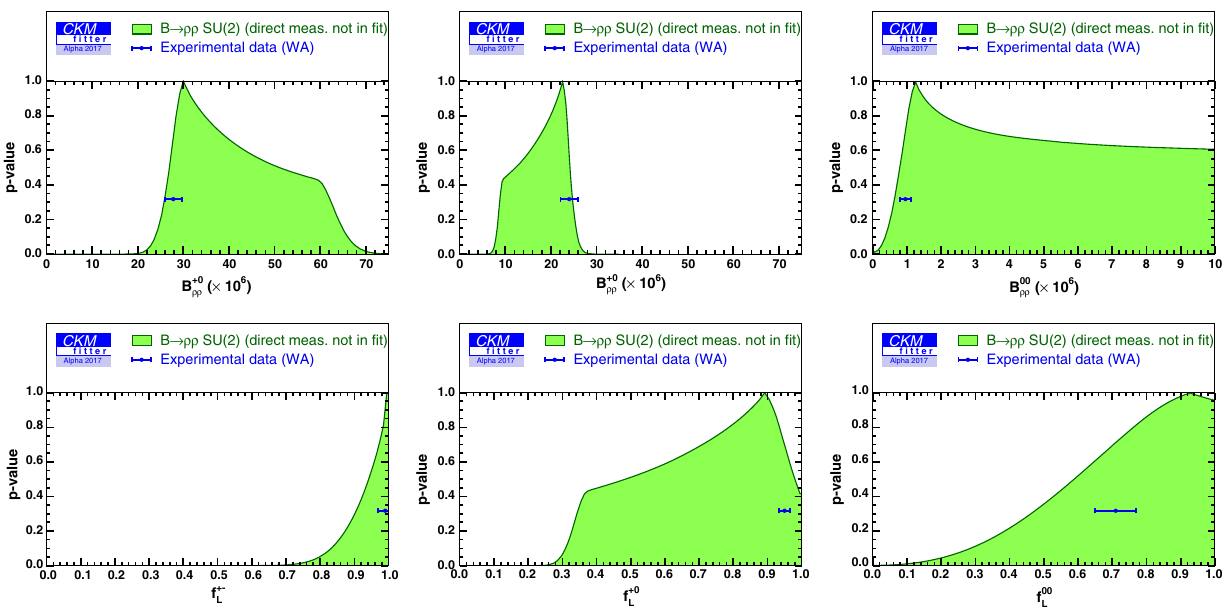
Fig. 29 SU ( 2 ) isospin constraint on the B → ρρ branching fractions ( top ) and the fractions of longitudinal polarisation ( bottom ). For each observable, the direct measurement, not included in the fit, is indicated by an interval with a dot